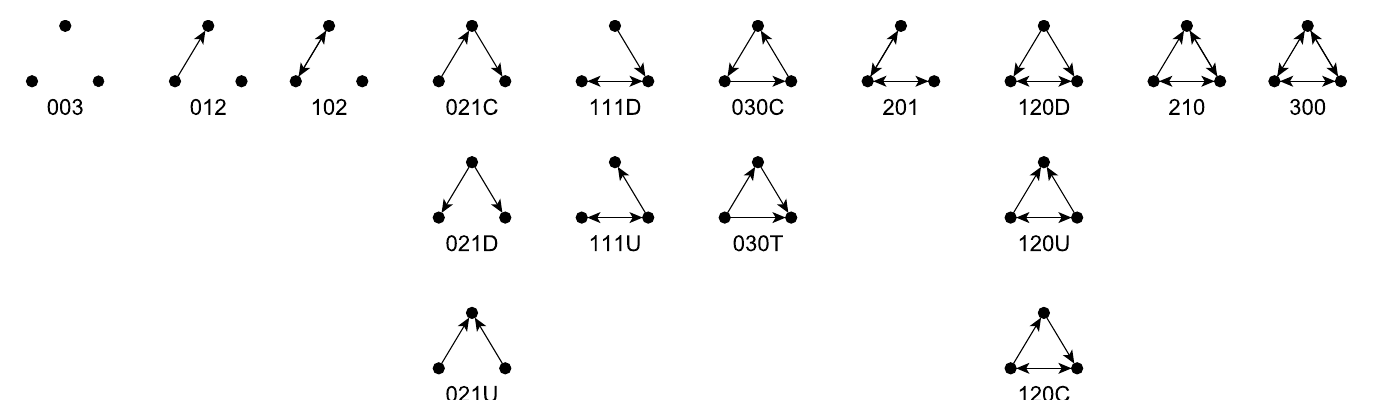
Fig 1. The collection of all triad types (triad census). The labels consist of three digits: the first digit denotes the number of mutual links ( $ ), the second stands for the number of arcs ( ! ) while the third denotes the number of missing links between two units. Some types of triads with the same distribution of links are further differentiated (see columns) and labeled with a letter (C stands for cycle, T for transitivity, U for up and D for down).